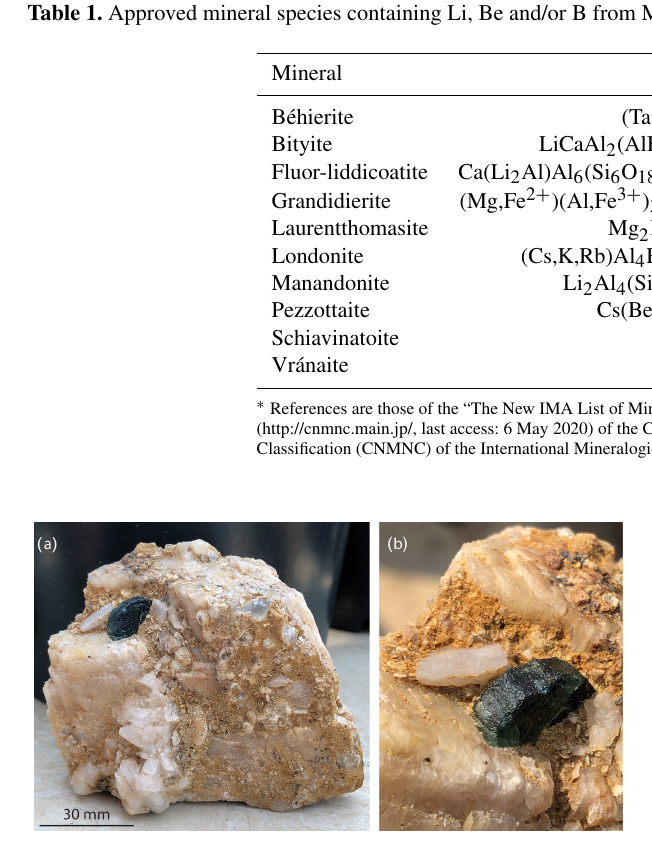
Figure 1. (a) Blue hexagonal crystal of laurentthomasite in par- tially weathered pegmatite mainly composed of quartz, orthoclase, phenakite and secondary apatite. (b) Enlargement of (a) .